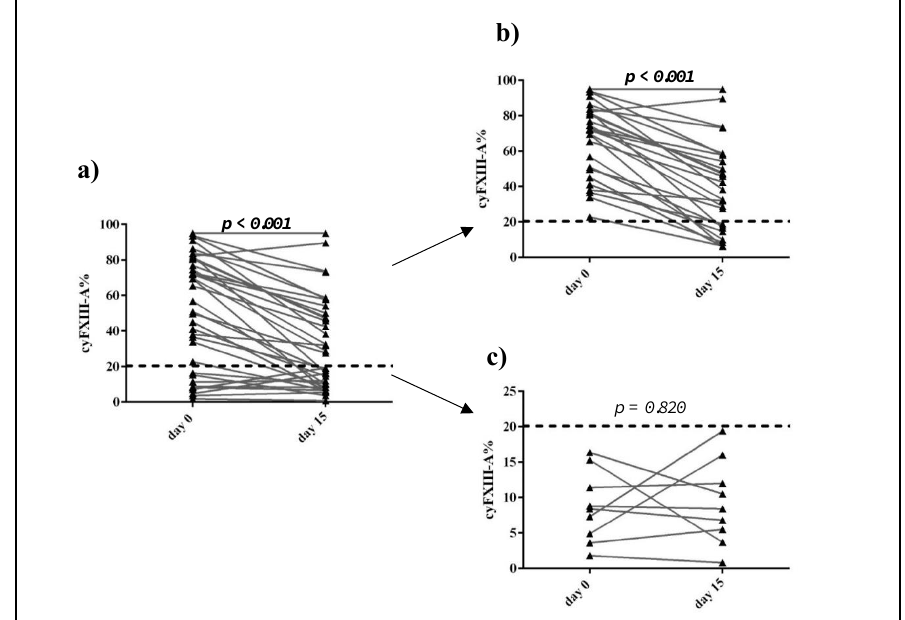
Figure 2. Ratio of FXIII-A expression of leukemic lymphoblast on Day 0 and Day 15. Thirty-six patients had FXIII-A expression data on Day 15 ( a ). Leukemic lymphoblasts were FXIII-A positive in 27 cases ( b ) and FXIII-A negative by 9 patients ( c ). FXIII-A expression of negative blasts was less than 20% (dashed line). p < 0.05 values were considered statistically significant, such p values are marked in bold. Cancers 2020 , 12 , x FOR PEER REVIEW